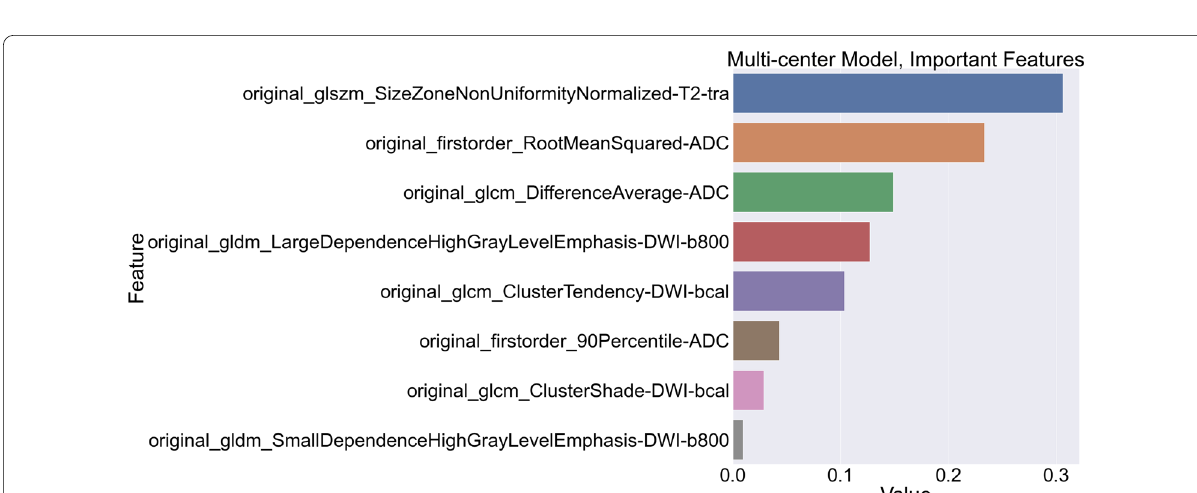
Fig. 5 “Gain” values for the top 8 most important features of the multi-center model trained on a dataset containing 171 multi-center PCa lesions. Higher gain means a higher positive effect on the end